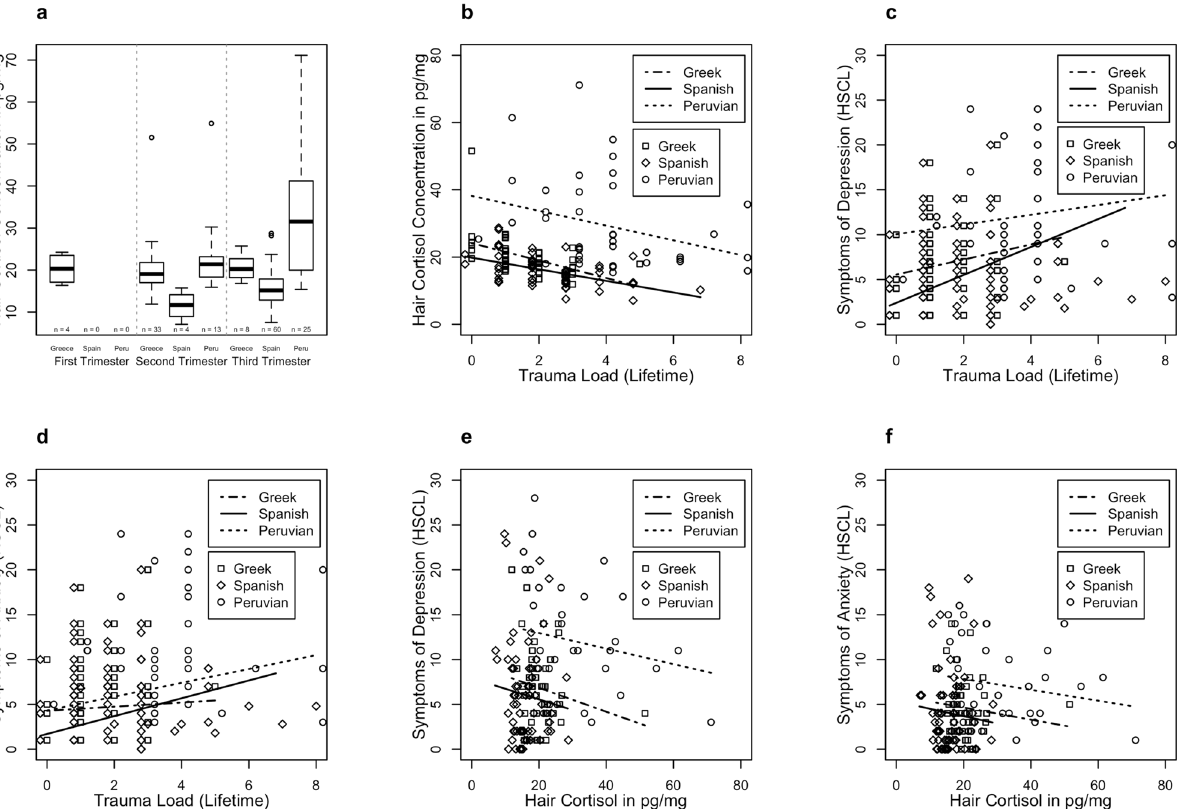
Figure 1. ( a ) Hair cortisol concentration (HCC) as a function of main trimester and group. ( b ) The relationship between lifetime trauma load and HCC, ( c ) trauma load and symptoms of depression and ( d ) anxiety as indicated by the Hopkins Symptom Checklist-25 (HSCL), and the relationship between HCC and ( e ) depression and ( f ) anxiety as indicated by the